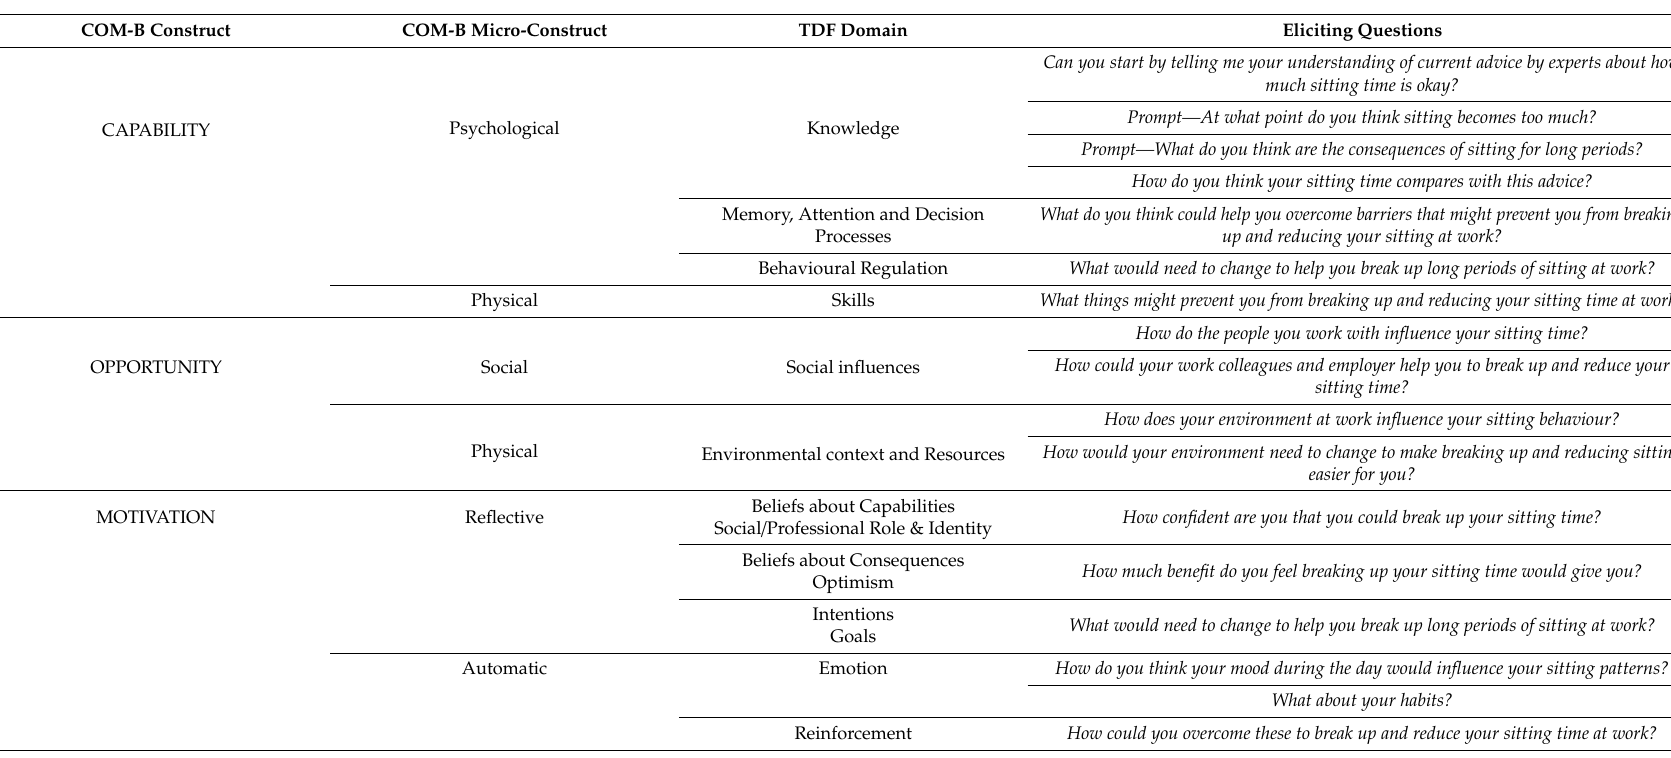
Table 1. Capability, Opportunity, and Motivation to Behaviour system (COM-B) / Theoretical Domains Framework (TDF)-informed interview